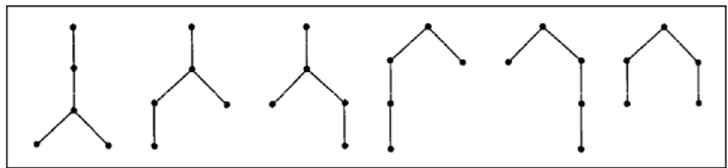
Figure 5. The set  , with five vertices, with three of them being